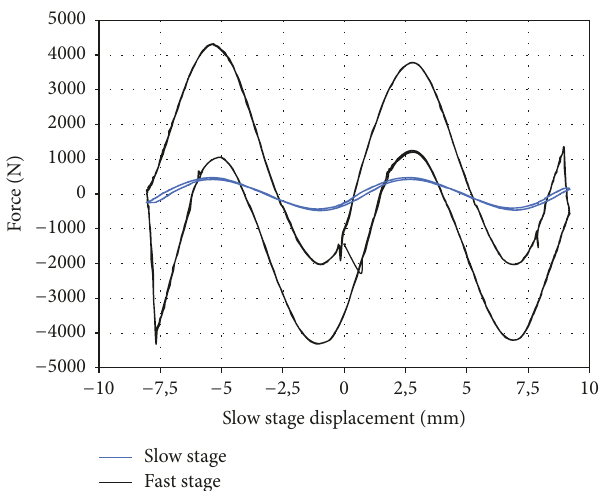
Figure 12: Slow and fast force versus slow stage displacement during quasistatic (0.1Hz) tests at room